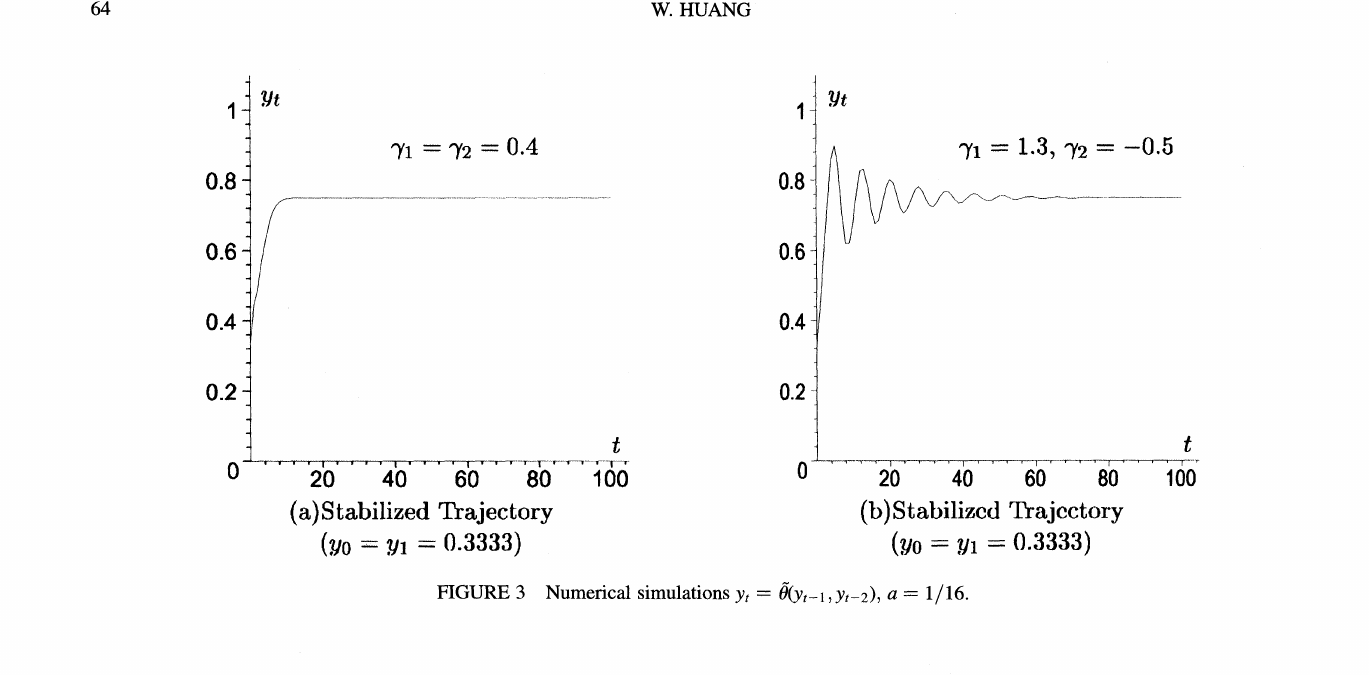
FIGURE 3 Numerical simulations Yt